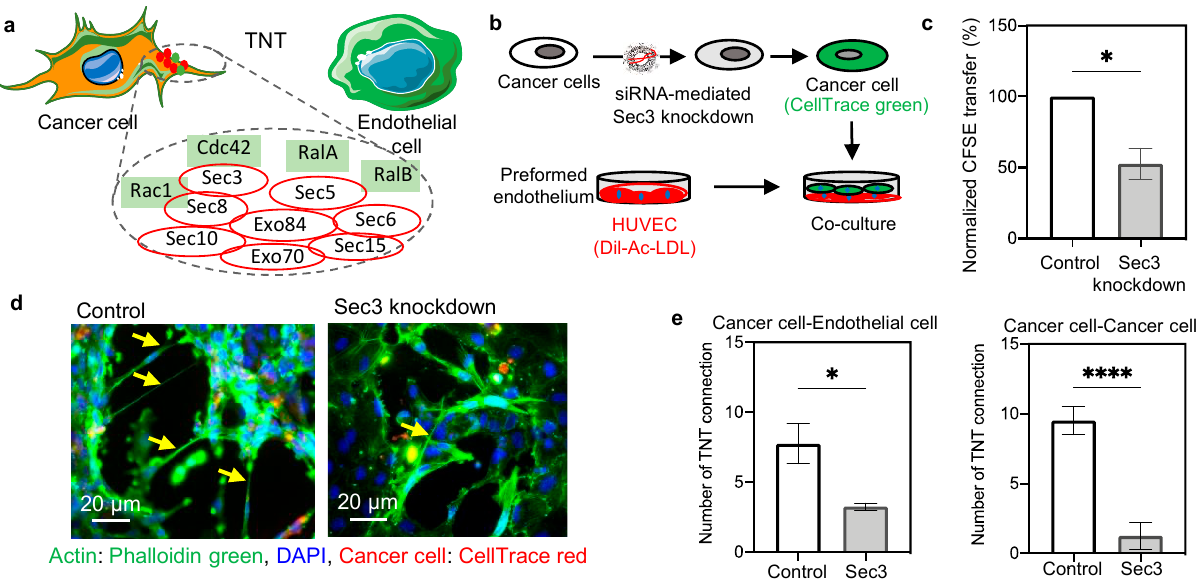
Figure 2. Involvement of exocyst proteins in TNT formation. ( a ) Schematic representation of the nanotube connection between a cancer cell and an endothelial cell and the involvement of actin remodeling pathway. The involvement of the exocyst complex and small GTPases in actin polymerization and TNT formation is shown schematically. The exocyst complex, is a combination of eight proteins (Sec3, Sec5, Sec6, Sec8, Sec10, Sec15, Exo70, and Exo84) that interact with small Ras GTPases (like, Cdc42, Rac1, RalA/B) to fulfill the energy requirement for the actin polymerization. ( b ) Schematic representation of the experimental design of the Sec3 knockdown in the cancer cells and the co-culture setup with preformed endothelium. ( c ) Graph showing the reduction of CFSE transfer upon knockdown of Sec3 (one of the major exocyst proteins) in cancer cells. siRNA-mediated knockdown of Sec3 was performed in cancer cells by lipofectamine-based transfection. Post knockdown, cancer cells were stained with CFSE and employed in co-culture with Dil-Ac-LDL stained HUVECs. After 24 h the amount of CFSE transfer was checked by FACS analysis and compared with the control (without Sec3 knockdown) condition. ( d ) Representative image of co-culture showing a reduced amount of TNT formation in the case of Sec3 knockdown of cancer cells. Cancer cells were stained with CellTrace red and co-cultured with unstained HUVECs. After 24 h, the co-culture was fixed, stained with phalloidin green and DAPI, and images were captured with an inverted fluorescence microscope. ( e ) Graph representing a quantification of the number of heterotypic (cancer cell–endothelial cell) and homotypic (cancer cell–cancer cell) nanoscale connections in the control and the Sec3 knockdown condition. The number of homotypic and heterotypic TNTs was counted from at least eight images in each control and knockdown group. The number of cancer cell–endothelial cell (heterotypic) and cancer cell–cancer cell (homotypic) TNT connections in the knockdown group was significantly reduced in comparison to the control group. Data are represented as ± SEM, and an unpaired two-tailed t -test was performed with Welch’s correction * p = 0.0215 (for cancer–endothelial) and **** p < 0.0001 (for